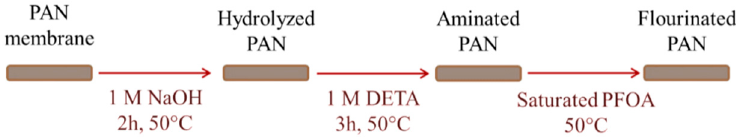
Figure 1. Schematic illustration of surface modification of PAN membrane (DETA = Diethylenetriamine, inspired from work in [63]).